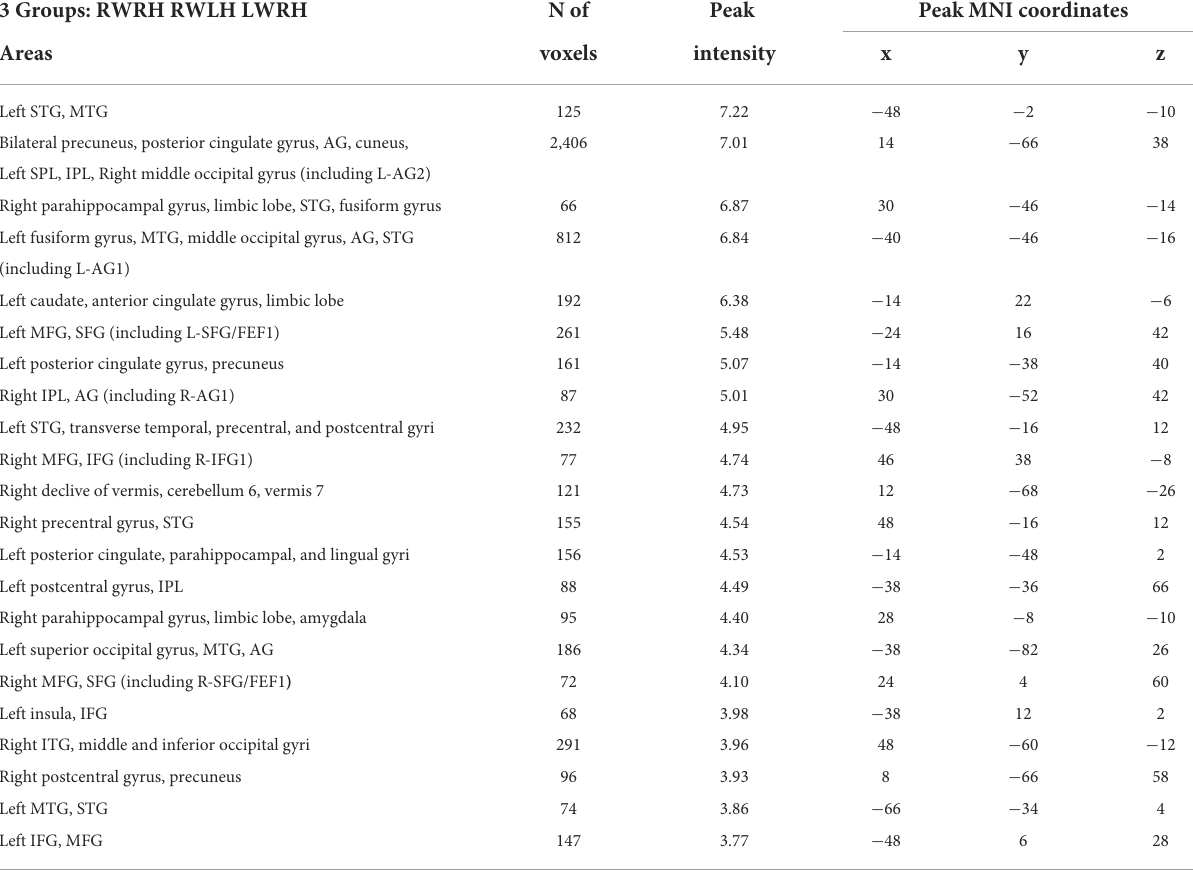
TABLE 2 Brain regions showing significant effects in the interaction between the factors group x session x target location, in the three-way ANOVA including the 3 groups (RWRH, RWLH, LWRH). 3 Groups: RWRH RWLH LWRH N of Peak Peak MNI coordinates Areas voxels intensity x y z